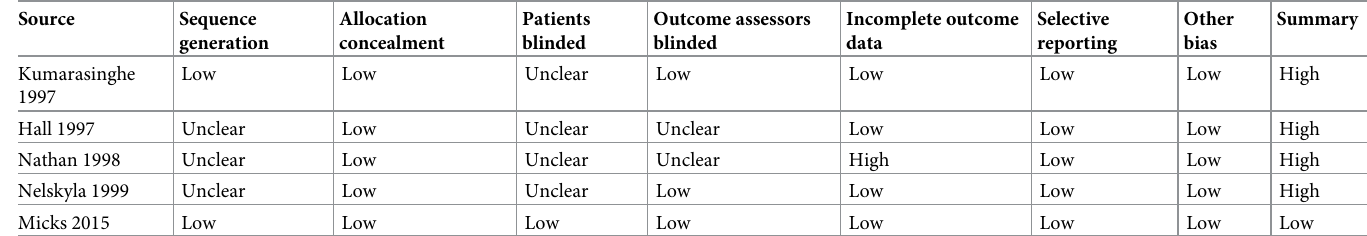
Table 2. Risk of bias of each trial.